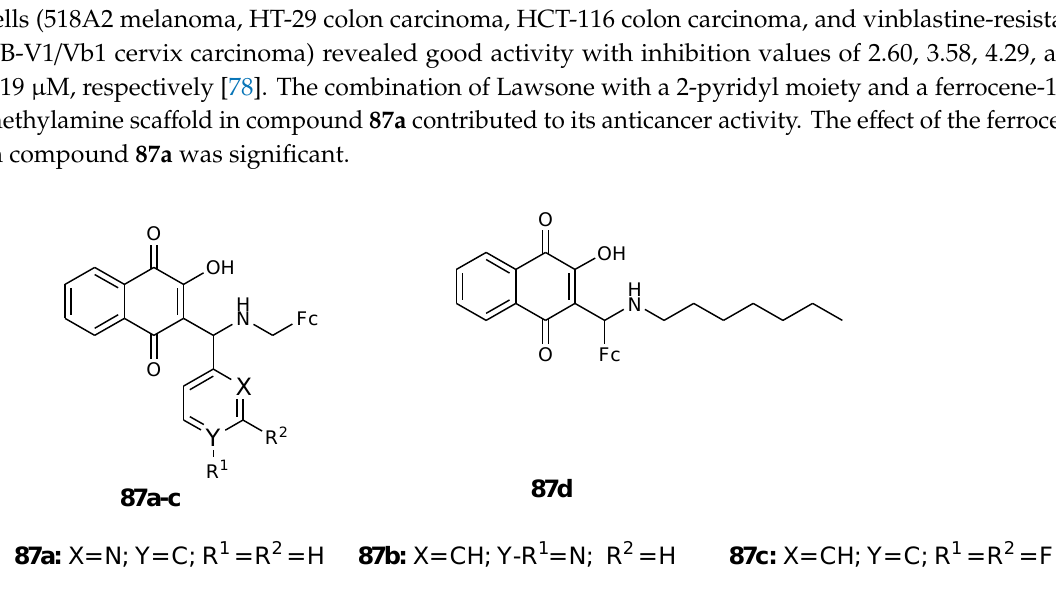
Figure 34. Chemical structures of ferrocene – Lawsone Mannich base derivatives ( 87a – d ).